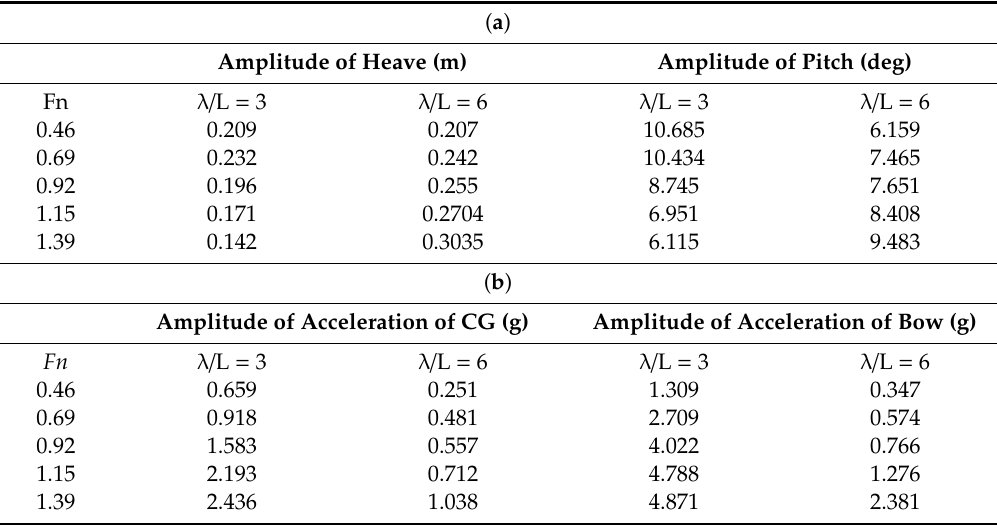
Table 16. The RAOs of the improved vessel at di ff erent speeds: ( a ) Heave and pitch; ( b ) Acceleration. ( a ) Amplitude of Heave